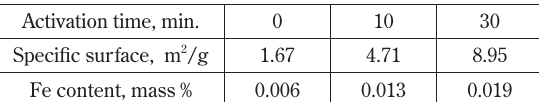
Specific surface and milled iron content de- pending on the time of mechanical activation of the samples Activation time, min.